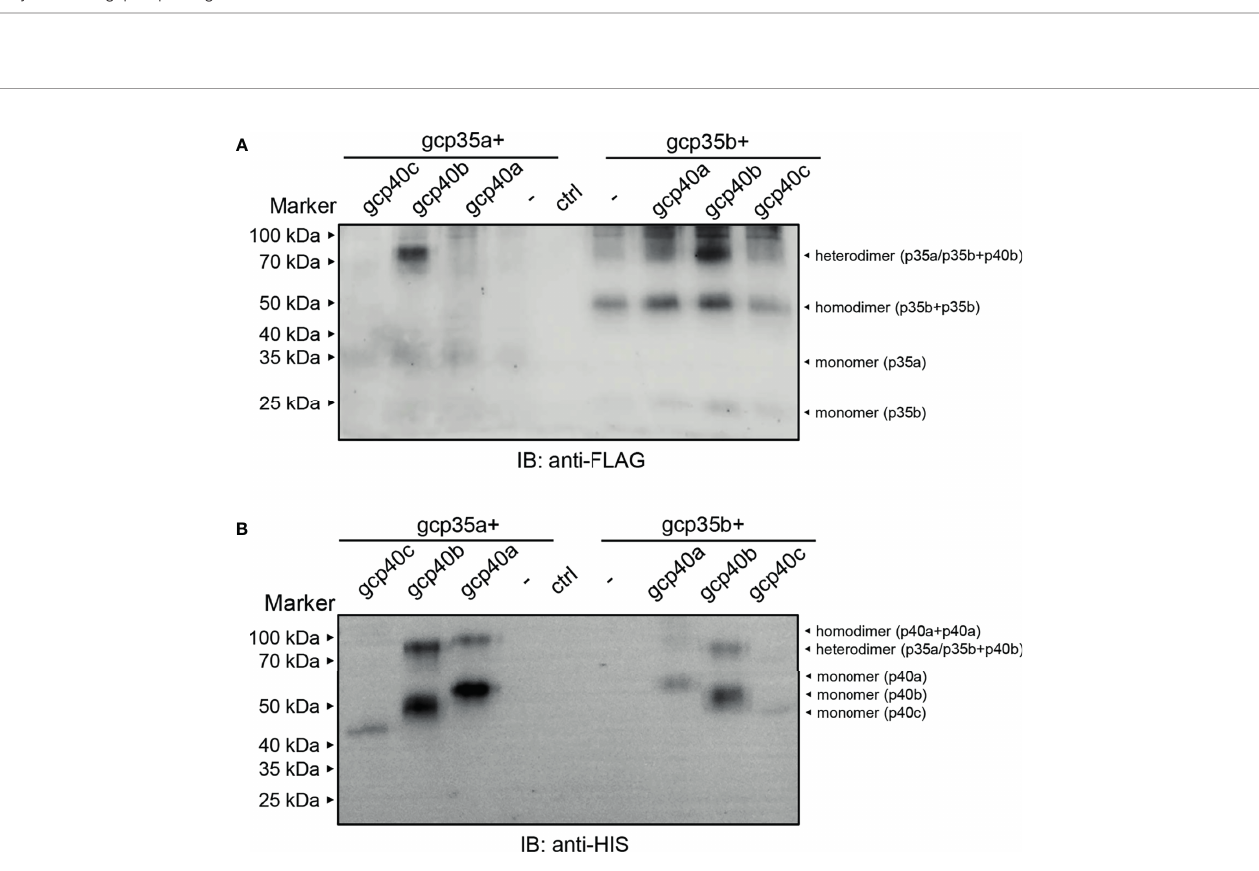
FIGURE 3 | 3D structural models of grass carp Il-12 isoforms. The structural models of grass carp Il-12 isoforms were constructed based on the human IL-12 crystal structure (PDB: 1F45). The exposed cysteines at the contact surface of gcp35 paralogues are marked with black arrows and the red arrows indicated the cysteines of gcp40 paralogues.